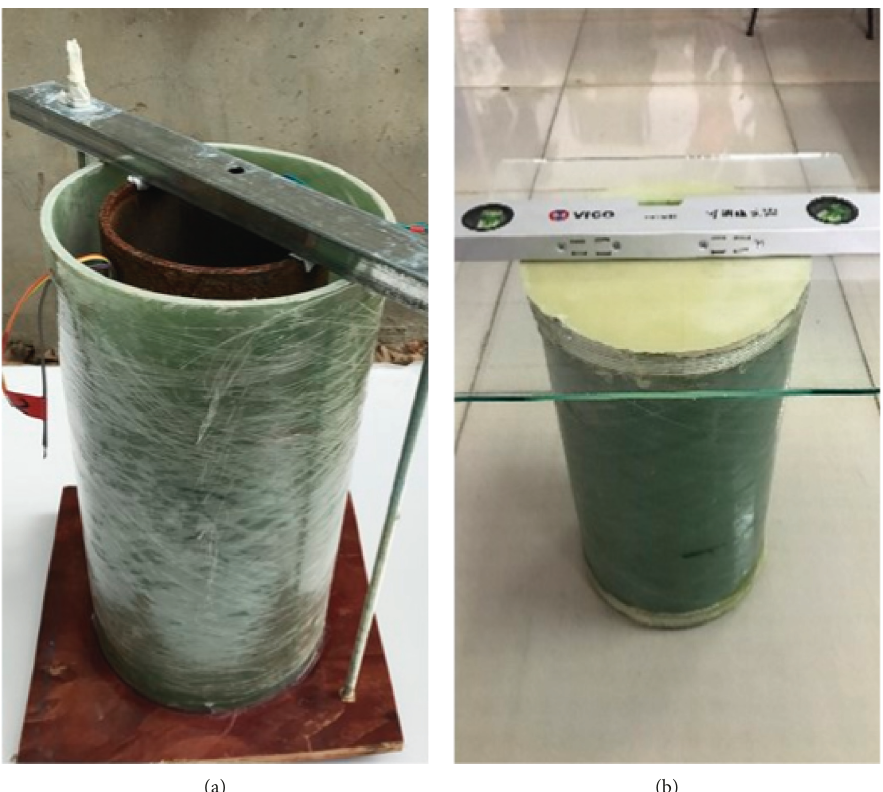
Figure 2: Preparation of hybrid DTCCs. (a) Formwork. (b) Gypsum capping.